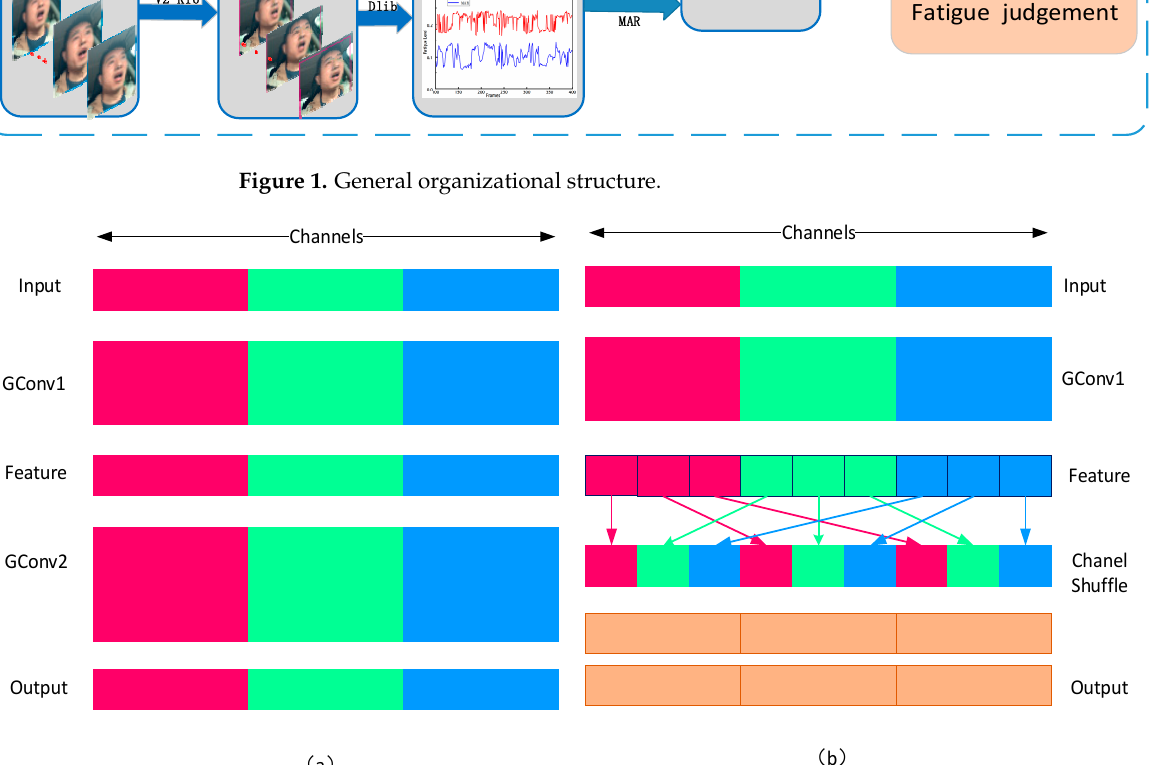
Figure 1. General organizational structure.